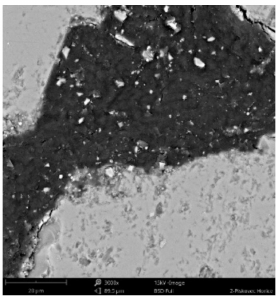
Figure 11. Phenom XL Desktop SEM photos. SEM results (average atomic concentration, average weight concentration and average stoichiometry weight concentration) in the form of graphs are shown in Figures 12–14.